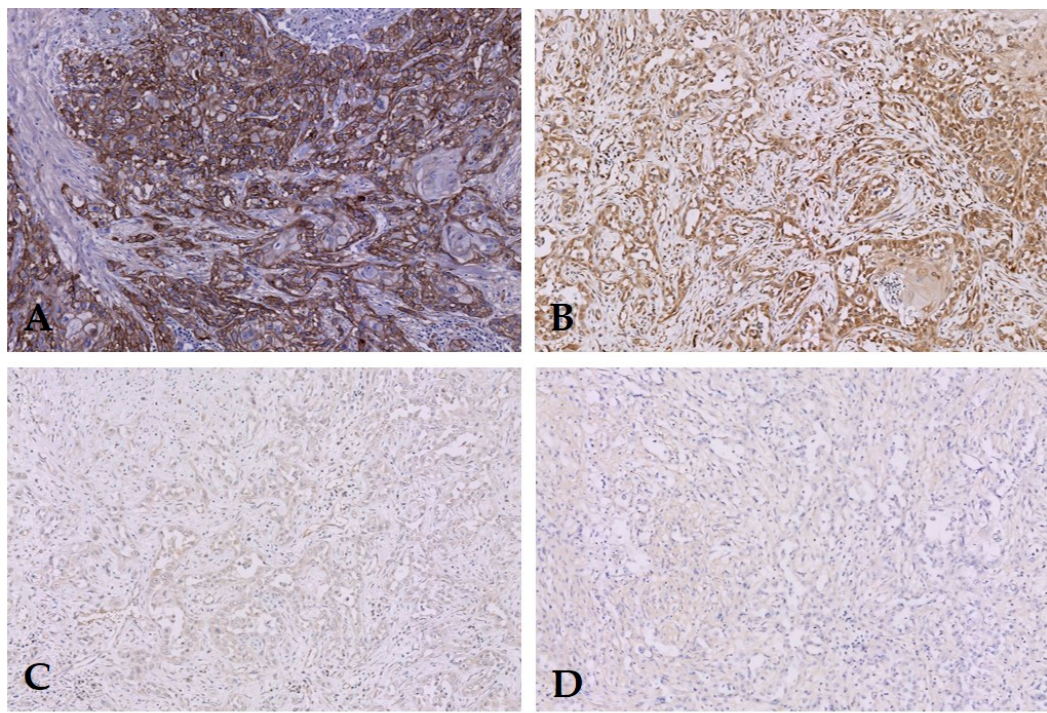
Figure 2. Lymph node metastasis of one patient with expression of ( A ) EGFR; ( B ) VEGF; no expression of ( C ) PSMA and ( D ) EpCAM. Original magnification 200×.